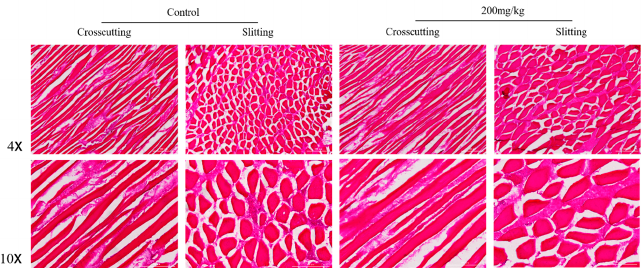
Figure 2. Light micrograph of HE staining showing the gastrocnemius muscle in which the mean fiber cross-sectional area has a wider diameter in 200 mg/kg L -theanine than in controls. Scale bar: 200 μ m.